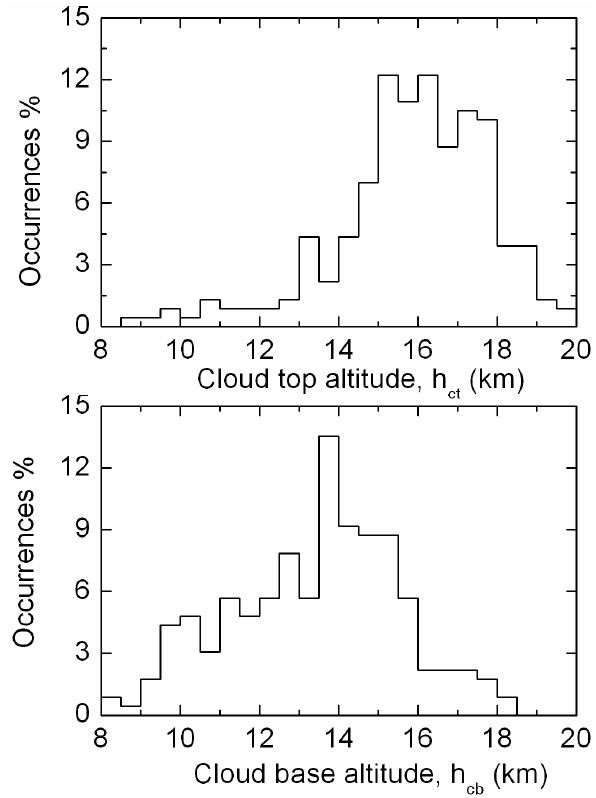
Fig. 7. Observed mean frequency distribution of the cloud top (h ct ) Figure 7 and cloud base ( h cb ) for tropical cirrus at Gadanki for the period